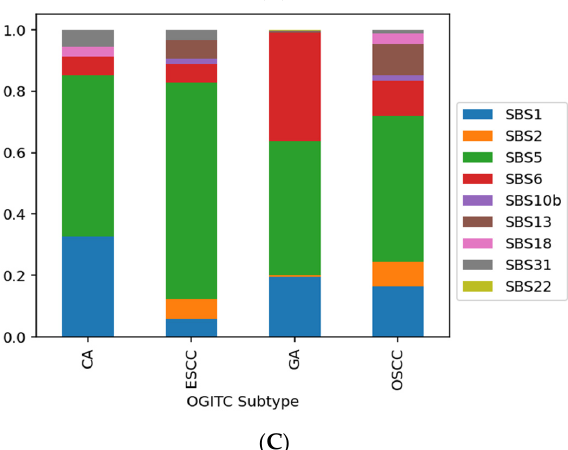
Figure 3. Mutational signatures in OGITCs. ( A ) Heatmap indicating the associated mutational signatures in this study. ( B ) Heatmap of the associated mutational signatures in the OSCC cohort from Chen et al. [42], and ( C ) mutational signatures of 54 OGITCs with proportions inferred from mutational signatures activities grouped to the specific subtype.